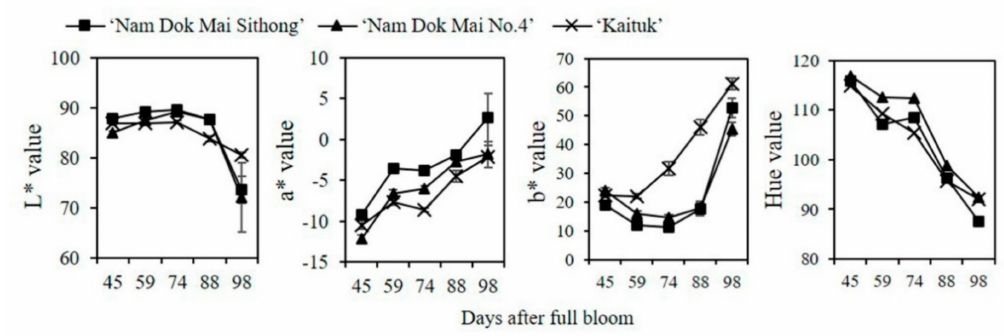
Figure 4. L*, a*, b*, and hue values in pulp of mango fruit cv. ‘Nam Dok Mai Sithong’, ‘Nam Dok Mai No. 4’ and ‘Kaituk’ during fruit development (45–88 days) and full ripening stage (98 days). The vertical bars represent the means with SE for three replications.